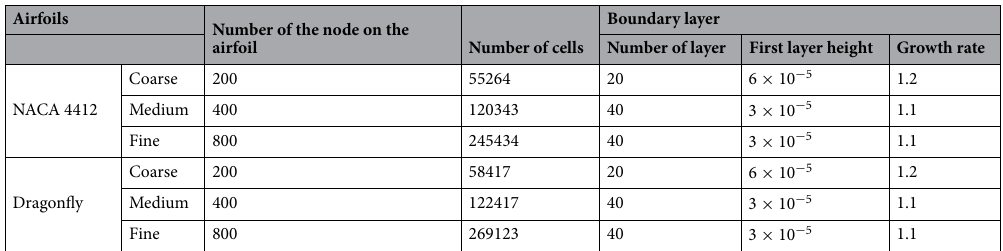
Table 2. Information of the computational